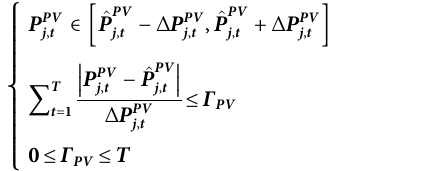
FIGURE 3 Topological structure of road network.